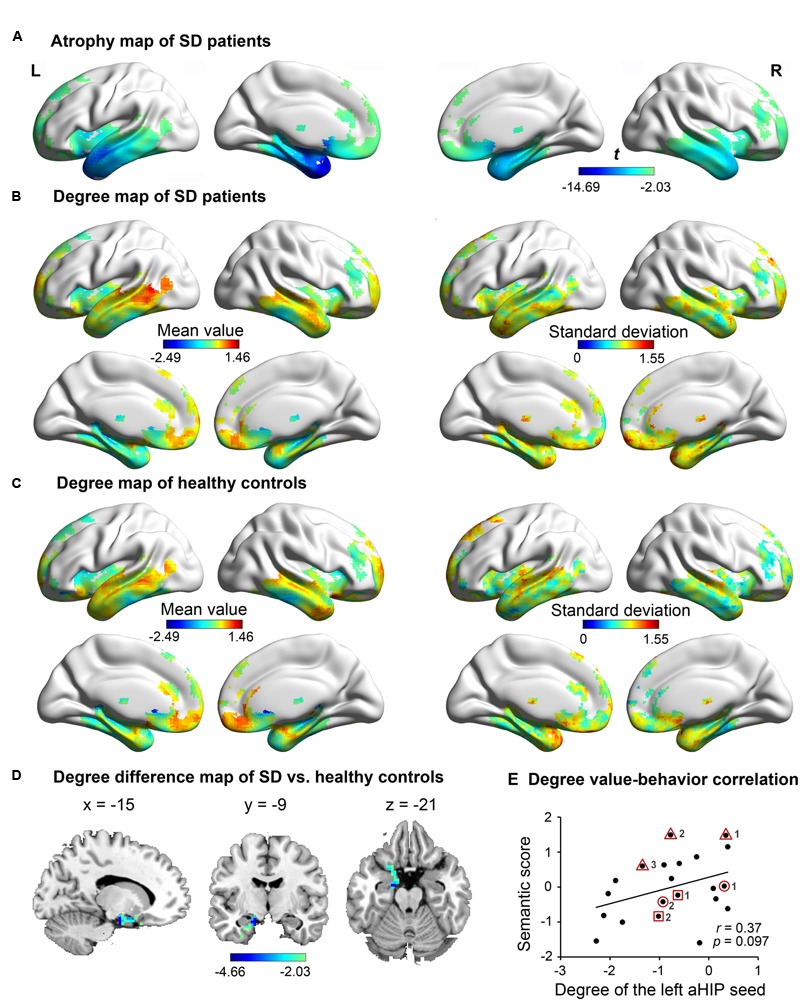
The atrophy and degree-centrality maps in subjects. In the atrophy map of SD (A), the degree centrality value of the left anterior hippocampus (aHIP) (D) was significantly lower in SD patients (B) relative to healthy controls (C) (AlphaSim corrected p < 0.05); (E) correlation of the left aHIP-seeded degree-centrality values with semantic composite scores in SD. [the geometric figures (circle, square, and triangle) and numbers circling the dots show the three patients with multiple observations and their observation times, respectively].